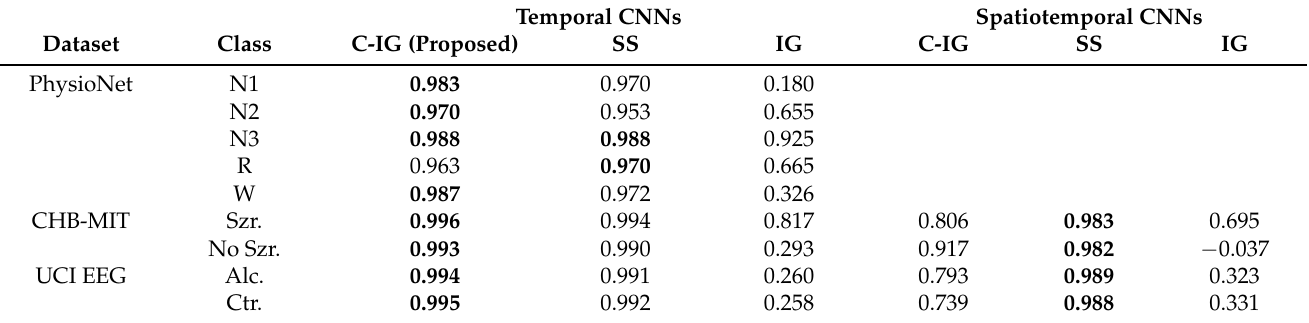
Table 1. Spearman’s correlation coefficient compared to contributions obtained using the Shapley sampling. The temporal and spatiotemporal CNNs, respectively, correspond to one- and two- dimensional convolutional CNNs.